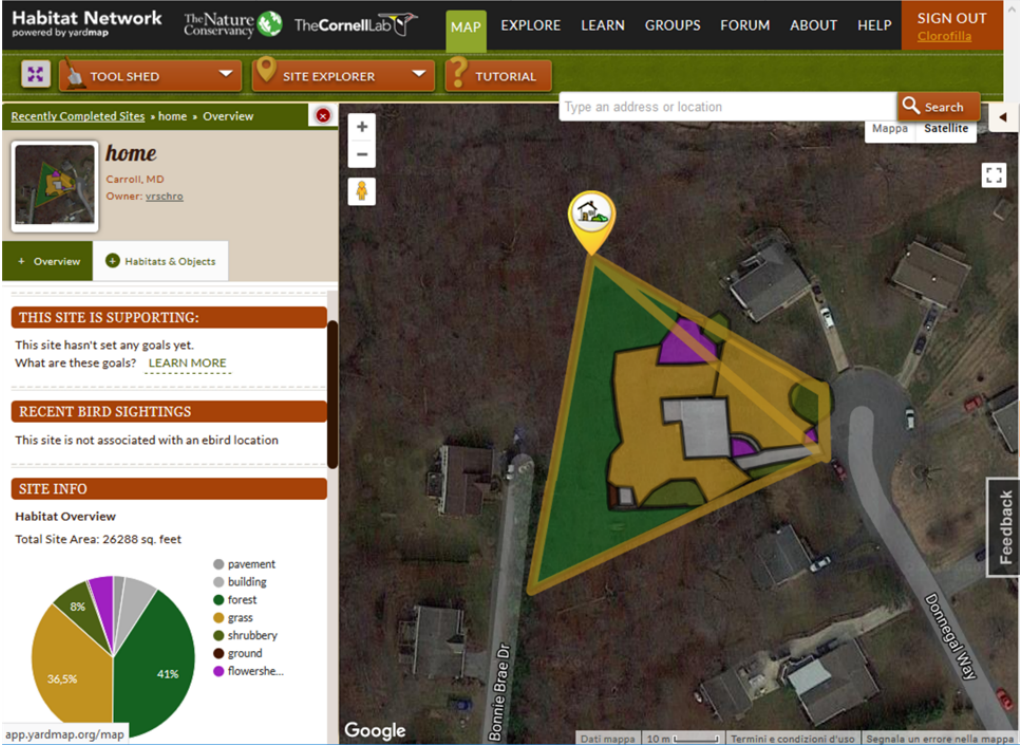
Figure 17. A view of the habitat network collaborative